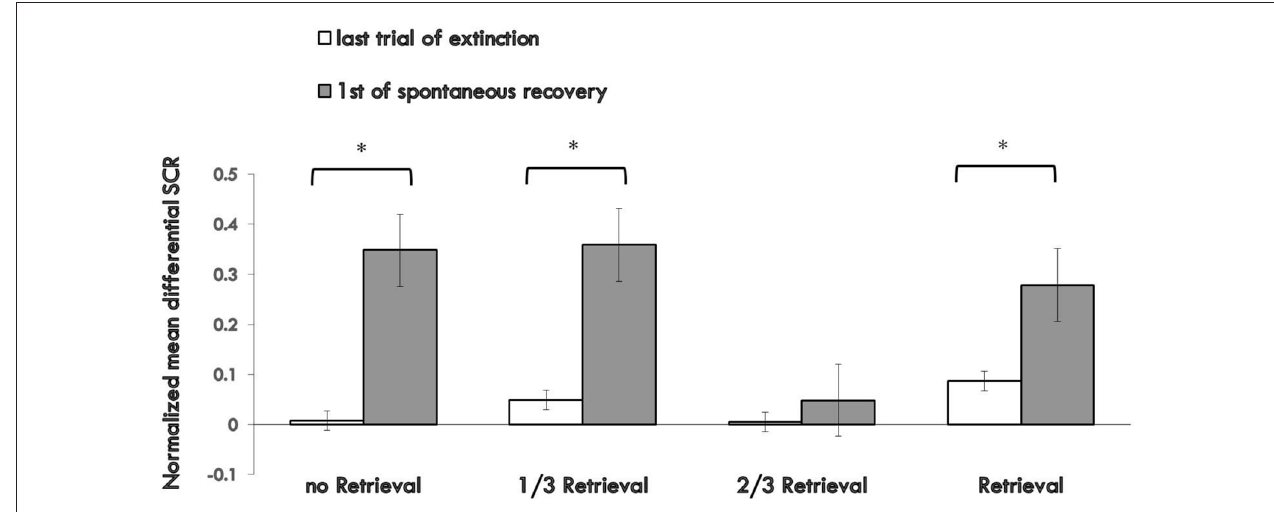
FIGURE 3 | Mean differential SCRs to the last trial of extinction and first trial of spontaneous recovery in each group. The ∗ represent p < 0.05. Error bars represent standard errors.